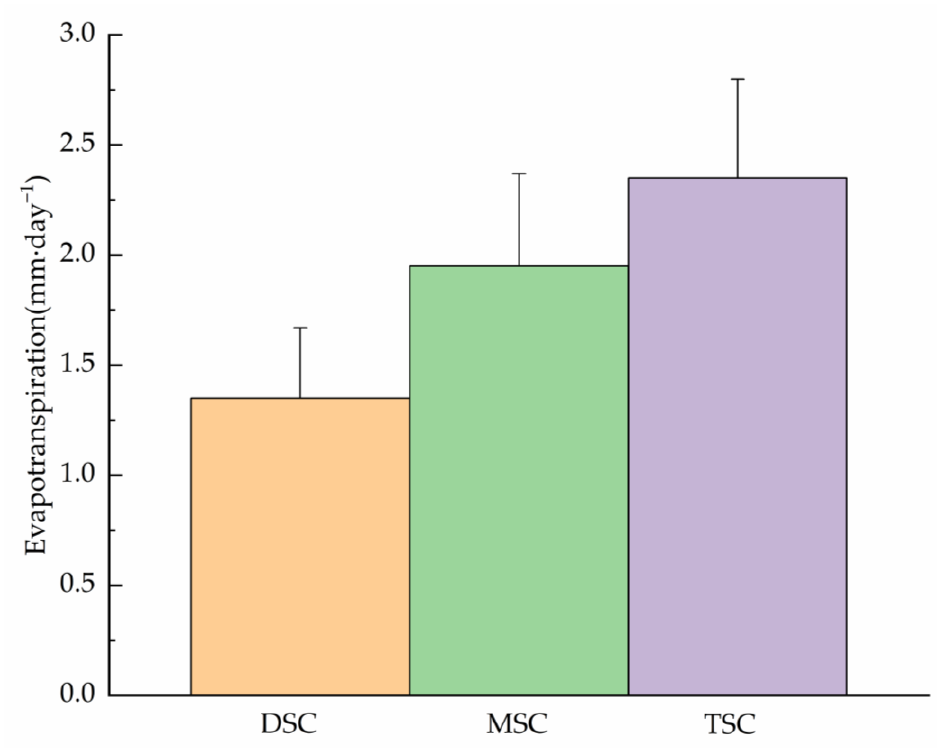
Figure 1. Daily average evapotranspiration rates between lysimeter (intact herbs and moss) under different shrub canopy coverage during the entire period of measurement (102 days) of 2012. Table 2. Results of mixed-model analysis of variance of moss evapotranspiration by different plots and lysimeter treatments for the entire measurement period.